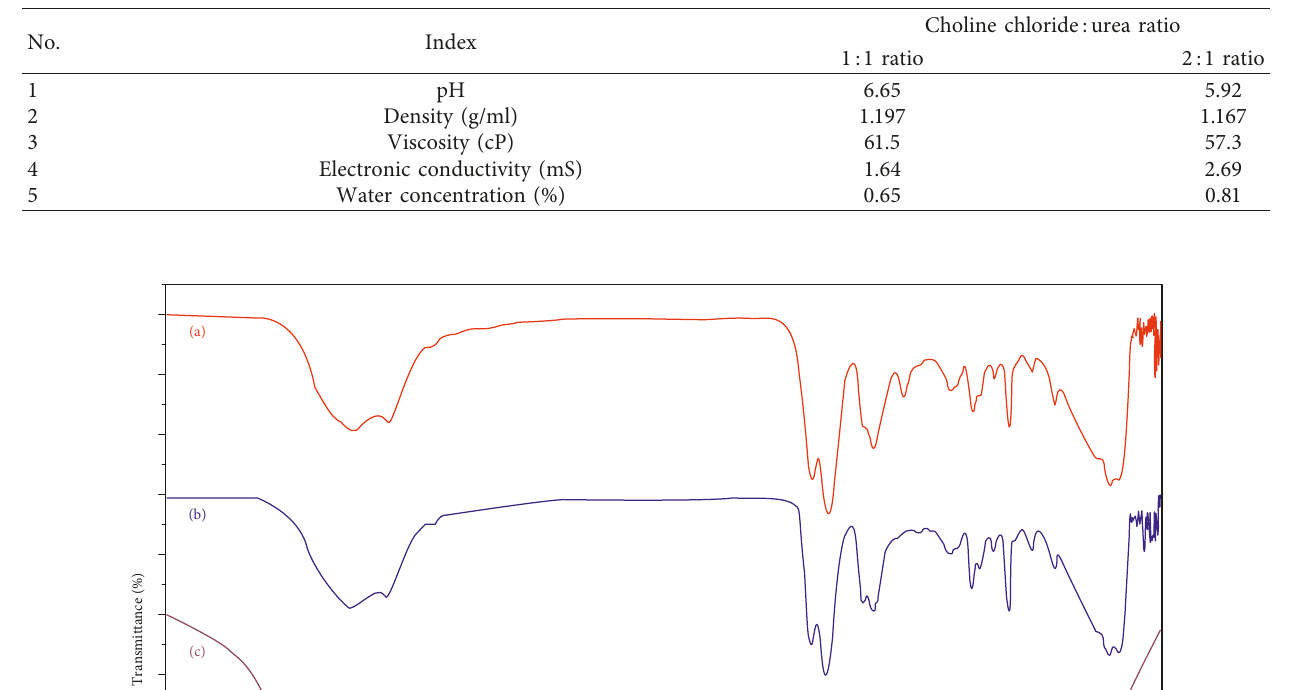
Table 2: Physical index of DES solution at 30 ° C.